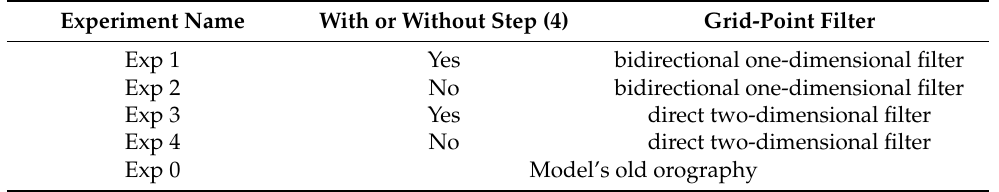
Table 1. Experiment settings.